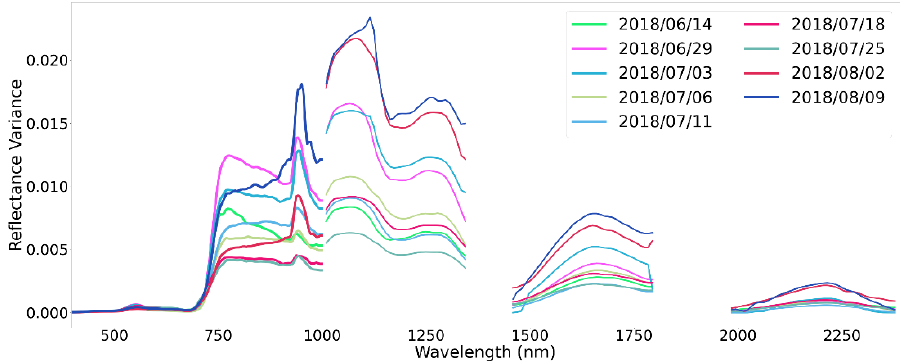
Figure A5. Example of reflectance variance of one of the varieties in HyCal-18 experiment (“Trudan 8”) during the 2018 growing season.